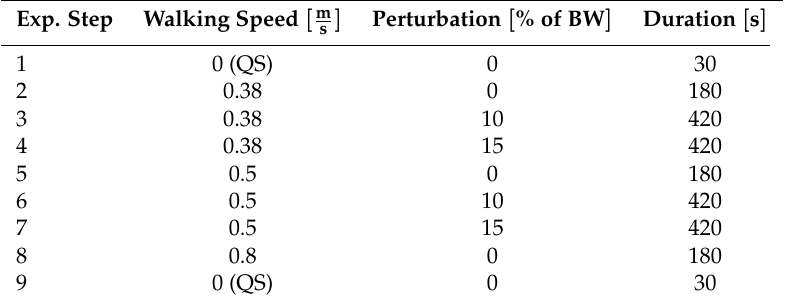
Table 1. Measurement protocol for healthy subjects. BW—body weight, QS—quiet standing. Exp. Step